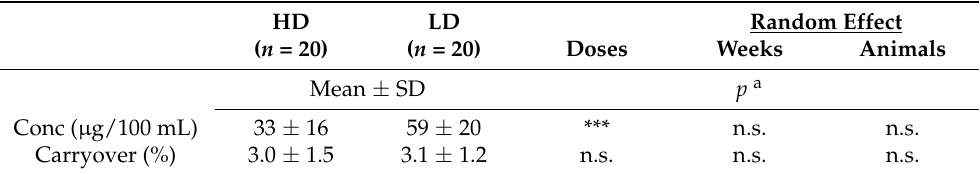
Table 1. Milk caffeine concentrations (mean ± SD) and milk caffeine carryover after 12 h from the last